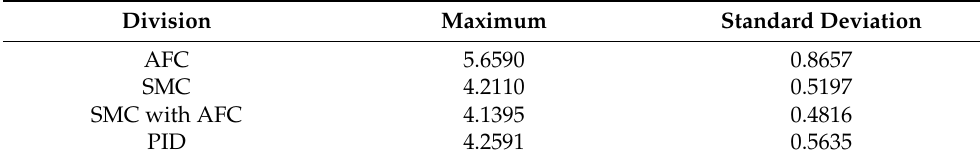
Figure 21. Results: trajectory comparison for the lane change. Table 5. Results of cost value comparison for the lane